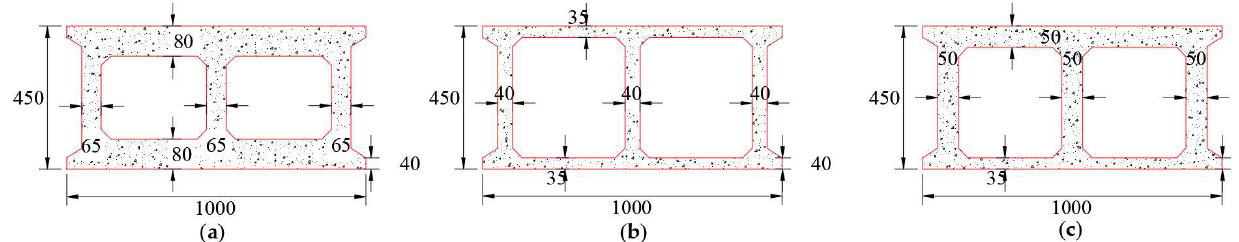
Figure 8. Diagram of the cross-sectional form of the arch ring: ( a ) section of arch foot; ( b ) L /4 cross section; ( c ) vault cross section. Units in cm.